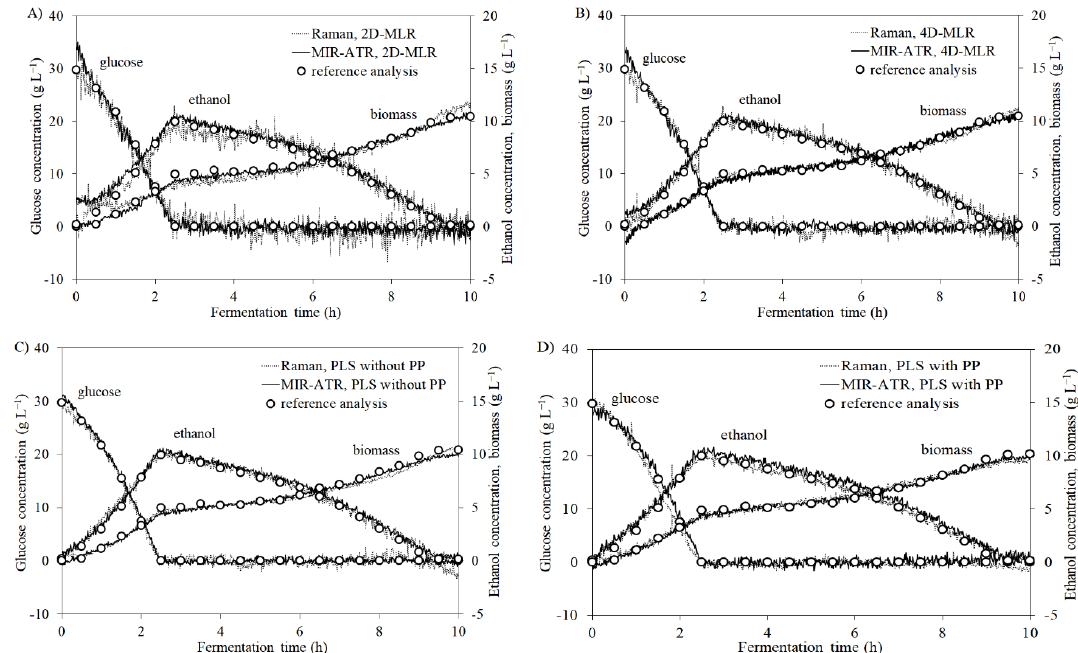
Figure 5. Predicted time-dependent concentration courses of glucose, ethanol, and biomass during batch-fermentation of S. cerevisiae . ( A ) 2D MLR, ( B ) 4D MLR, ( C ) PLS without pre-processing (PP), ( D ) PLS with PP. Comparison of real-time measurement data by Raman and MIR-ATR with off-line reference values (HPLC, gravimetry).